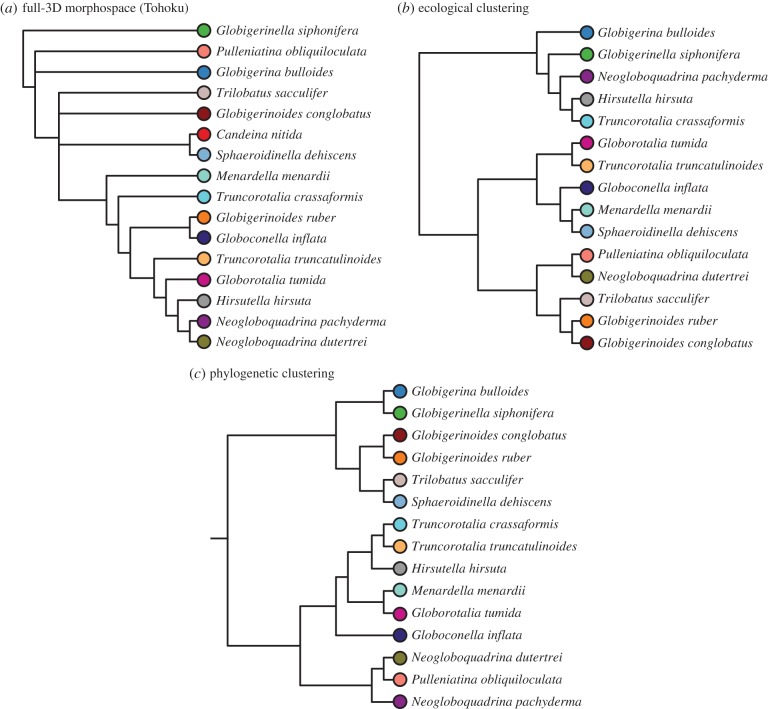
Ecological and phylogenetic clustering of the 15 macroperforate species that overlap between the Tohoku University dataset and the coretop/exemplar dataset. (a) Consensus cluster dendrogram of the full-3D Tohoku University specimen morphospace (same as figure 10c). (b) Ecological cluster dendrogram built using Jaccard distances calculated from three ecological traits (table 1). (c) The phylogenetic relationships between the 15 macroperforate species, as pruned and redrawn from Aze et al.'s [22] stratophenetic phylogeny. Dendrogram tip label colours correspond to morphospace species colours from figure 9.